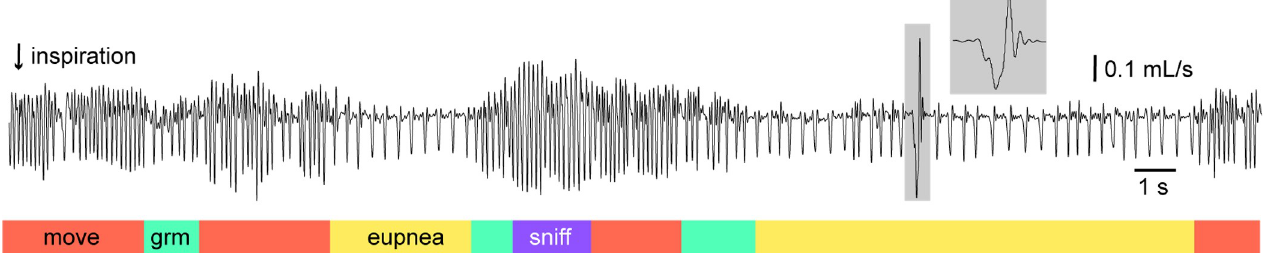
Fig 4. Breathing in an awake, intact adult mouse. A 30 sec continuous sample of breathing via whole-body plethysmography in a CD-1 mouse. Inspiratory airflow points down. The trace shows exploratory movements (orange), grooming (green), and high-frequency sniffing (purple), in addition to eupnea (yellow). One sigh (gray, expanded in the inset) characterized by 2-fold larger inspiration compared to a typical eupneic breath, followed by expiration. Time and airflow calibrations are shown. Raw data can be found in the Supporting information (S1 Data).